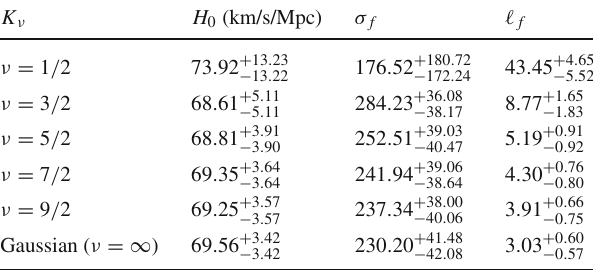
Table 2 Average values of H 0 and hyperparameters ( σ f ,(cid:5) f ) for differ- ent kernels and 500 mock realisations of the data. There is a descending trend in the errors on H 0 as we increase the GP kernel parameter ν , so the final result is kernel